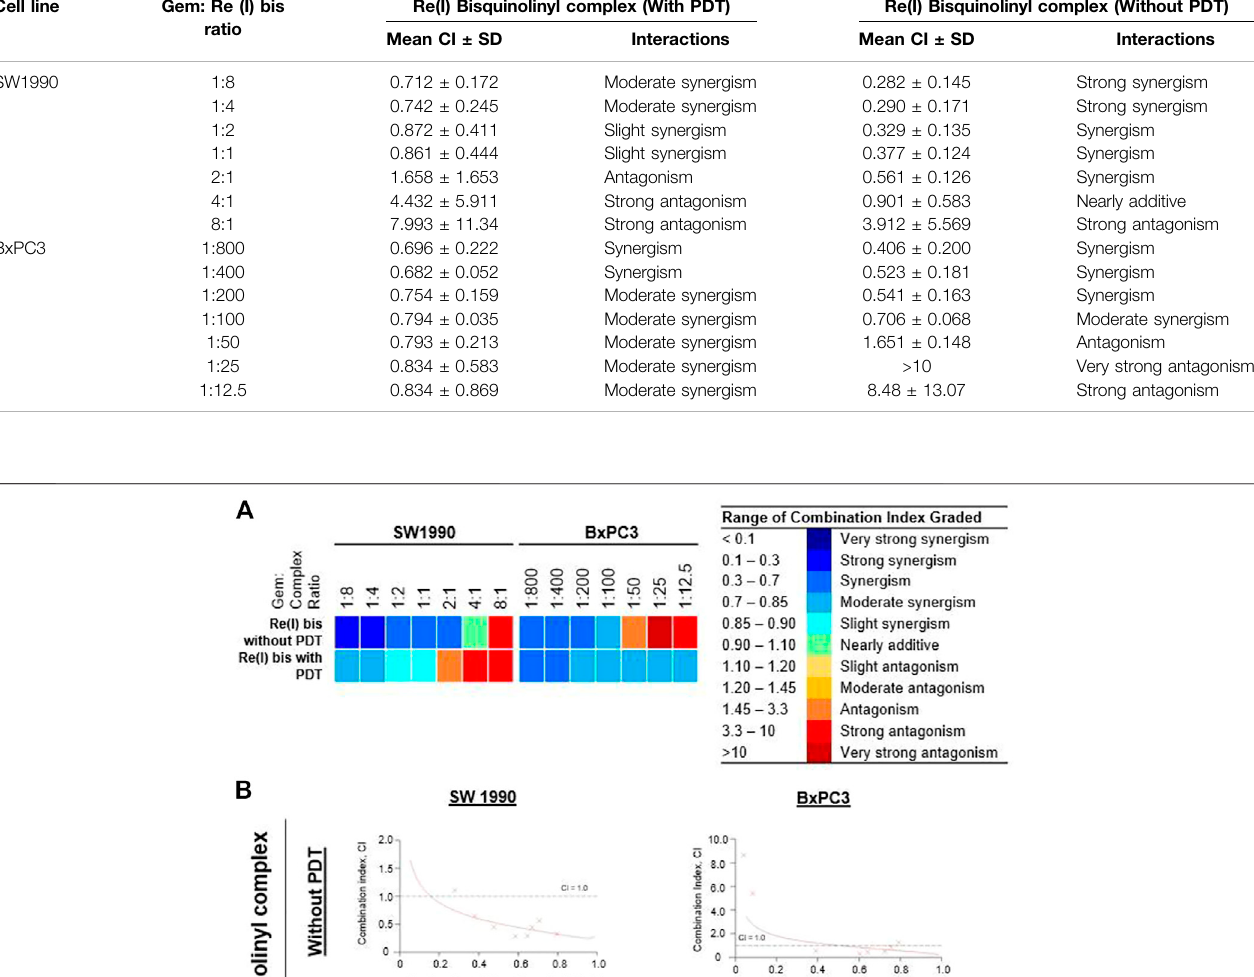
TABLE 3 | Summary of combination index (CI) for gemcitabine combination with Re(I) bisquinolinyl complex in pancreatic cancer cells with or without PDT. Cell line Gem: Re (I) bis Re(I) Bisquinolinyl complex (With PDT) ratio